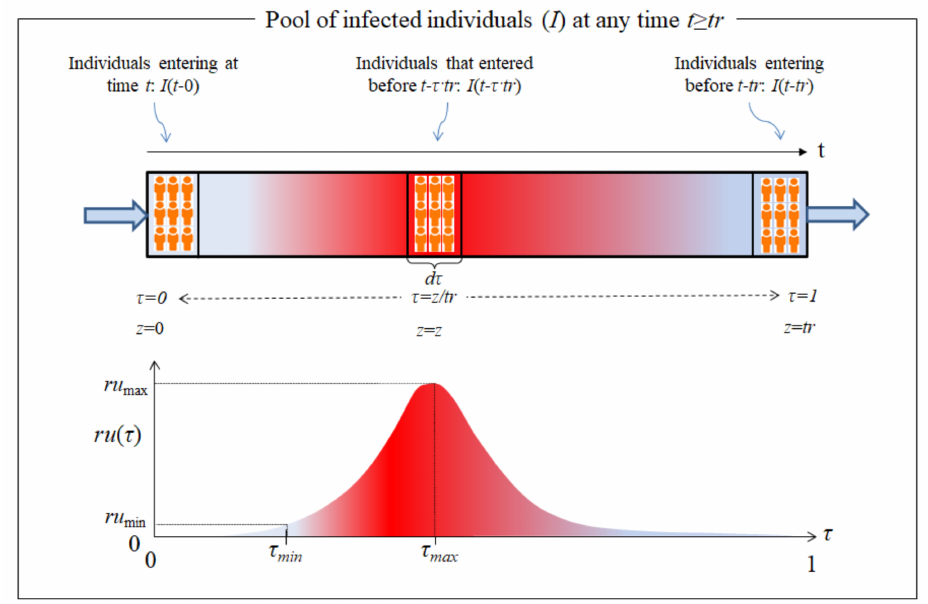
Figure 1. Top: the I pool as it behaves over time, t . Bottom: the transit of a single patient through the I pool is delimited from the time of infection (inlet at τ = 0) to the end of the sickness (outlet at τ = 1). There is another particular case that occurs when the time elapsed from the beginning of the pandemic is t < tr . In this case, “patient zero” is located on the “moving walkway” at τ = t / tr and has not yet left the I pool, the end of which is located at τ = 1. As result, the “moving walkway” is empty in the interval [ τ , 1]. Other than this special case, all patients start the transit through the I pool at τ = 0 and exit at τ =